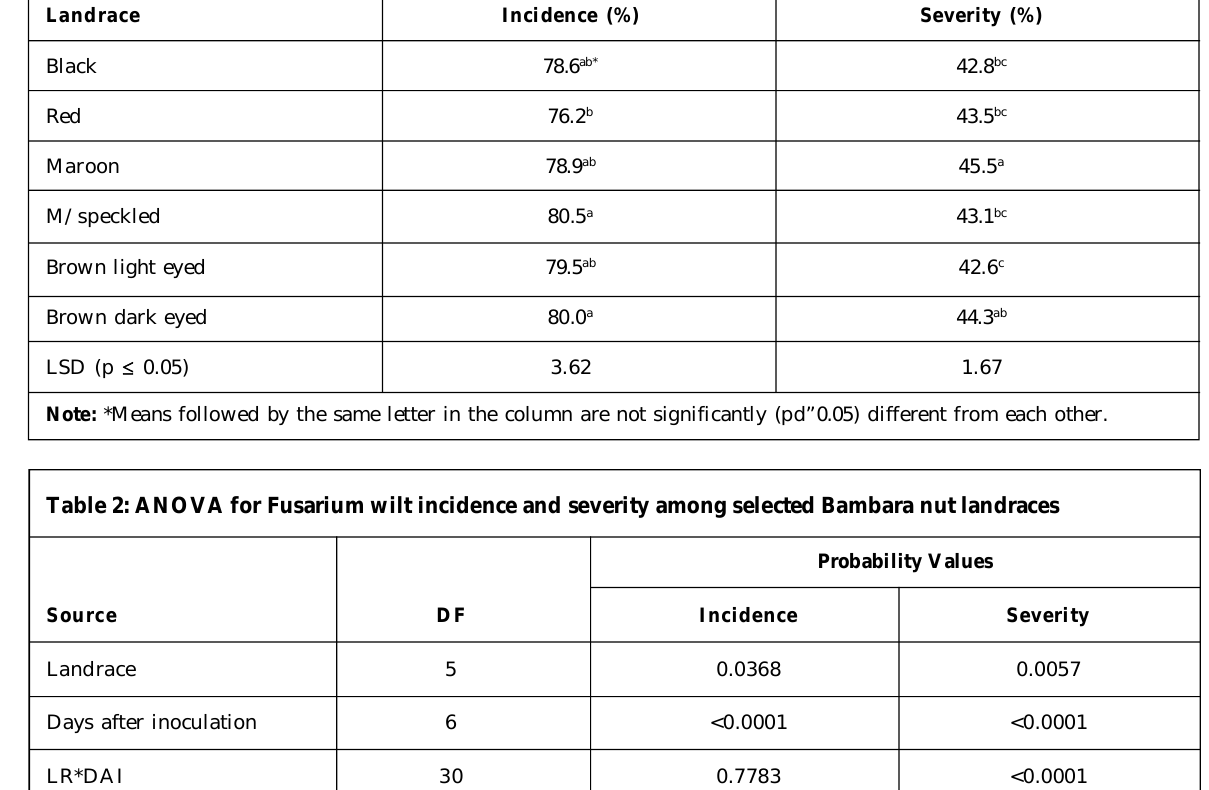
Table 1: Fusarium wilt incidence and severity among the local landraces of Bambara nut Landrace Incidence (%) Severity (%) Black 78.6